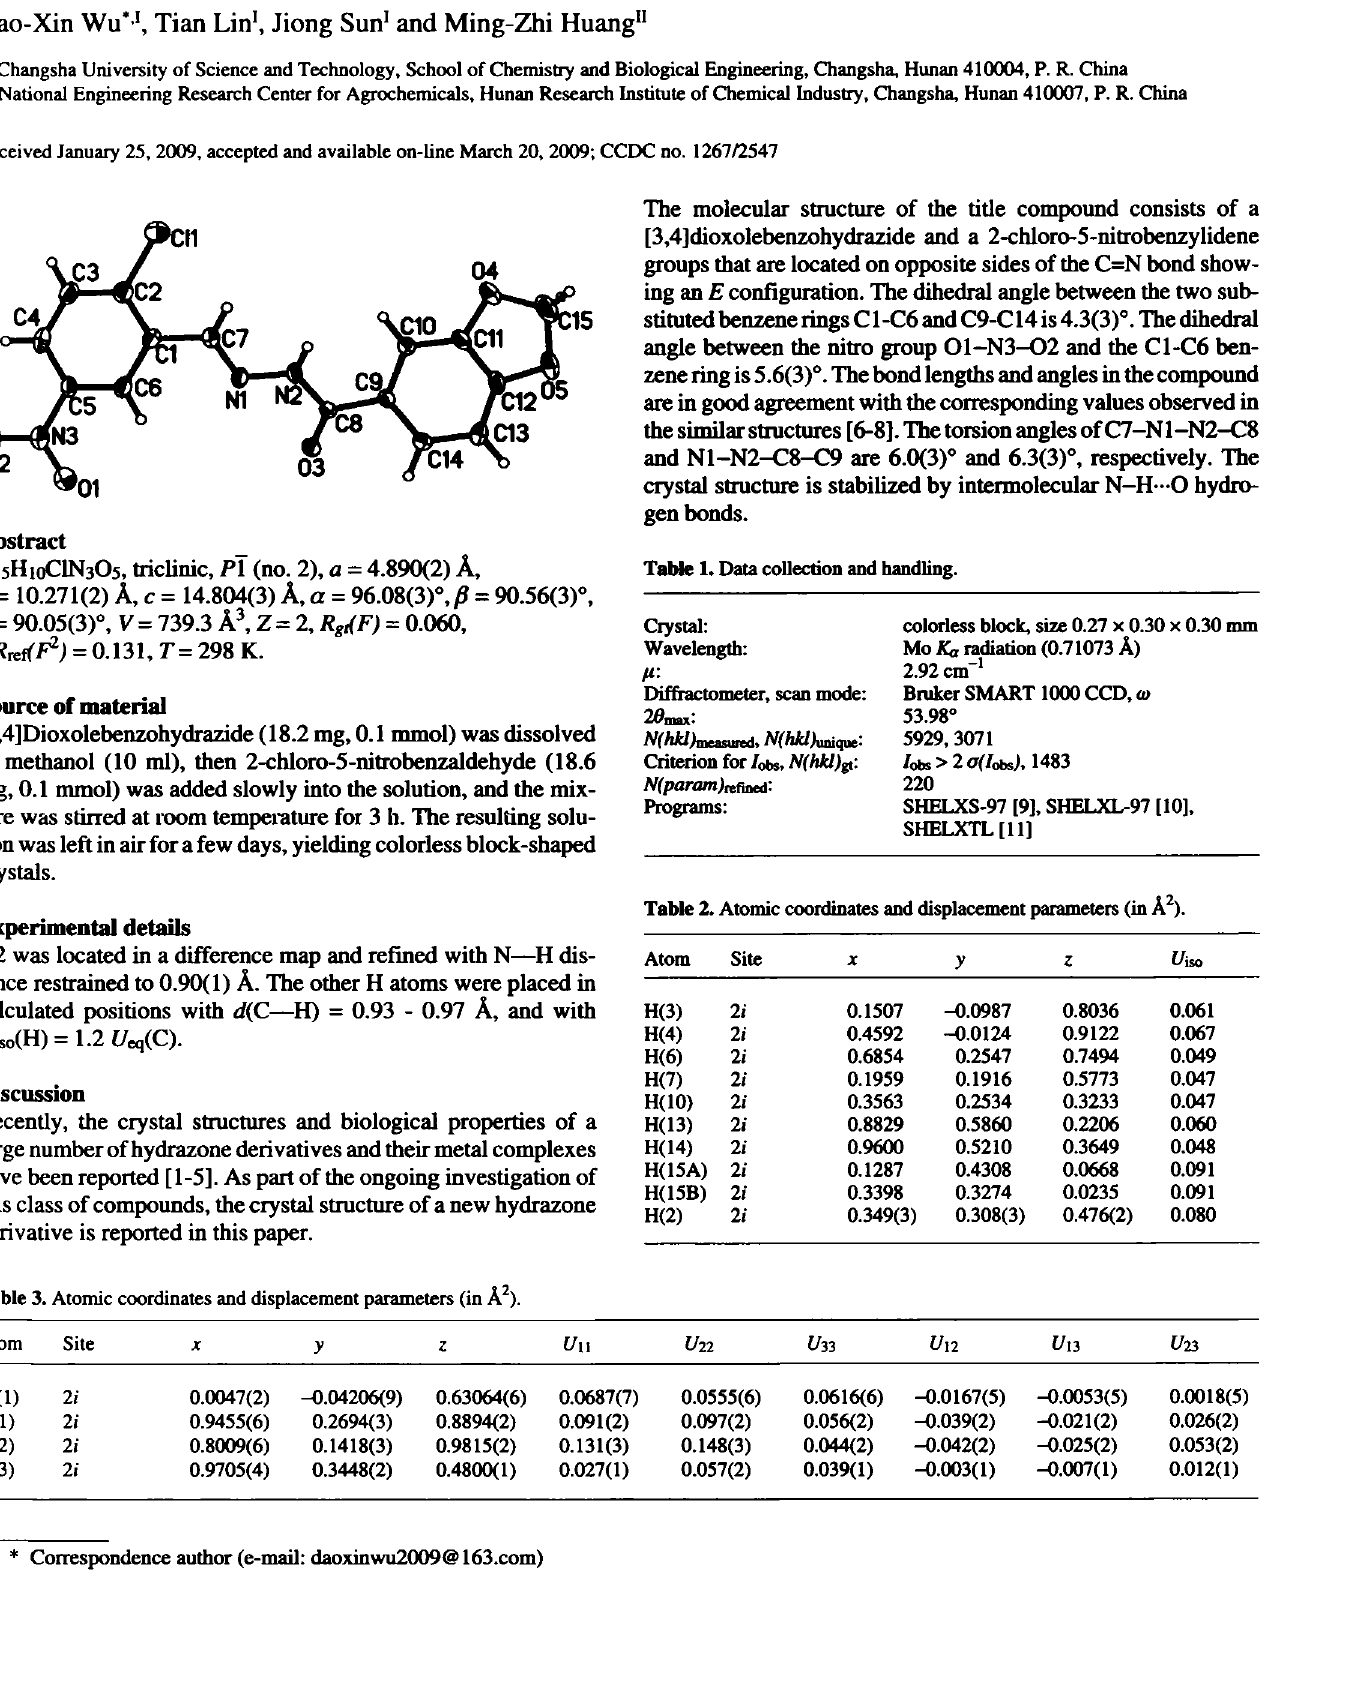
Table 3. Atomic coordinates and displacement parameters (in Â 2 ).